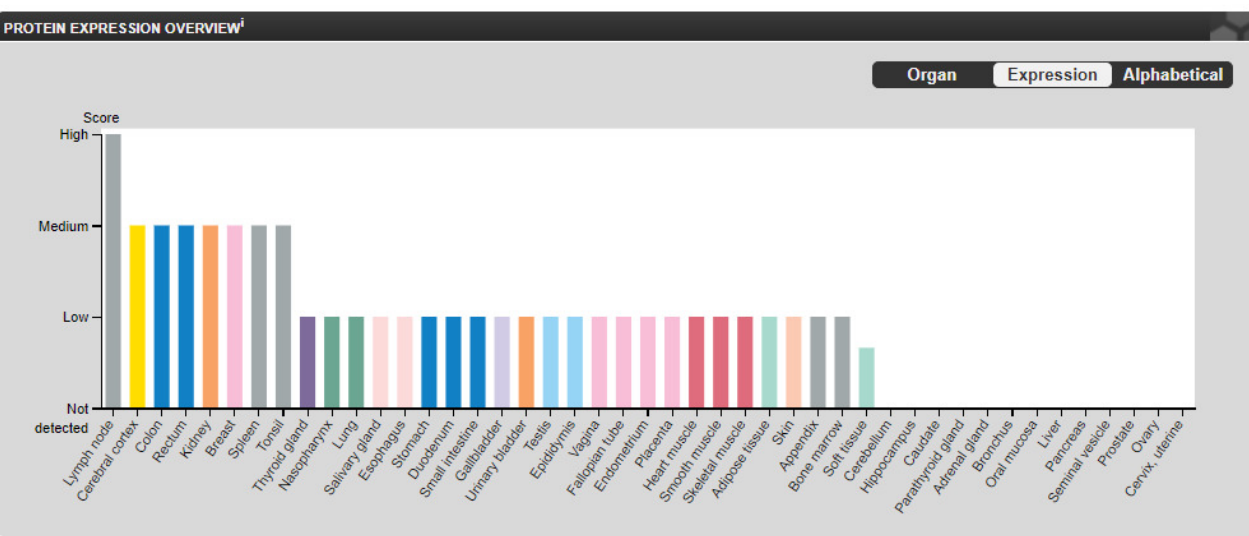
FIGURE 7 - Expression of CDC25B in organs. Nuclear and cytoplasmic expression in several organs, most abundant in Lymph node, Cerebral cortex, Colon and